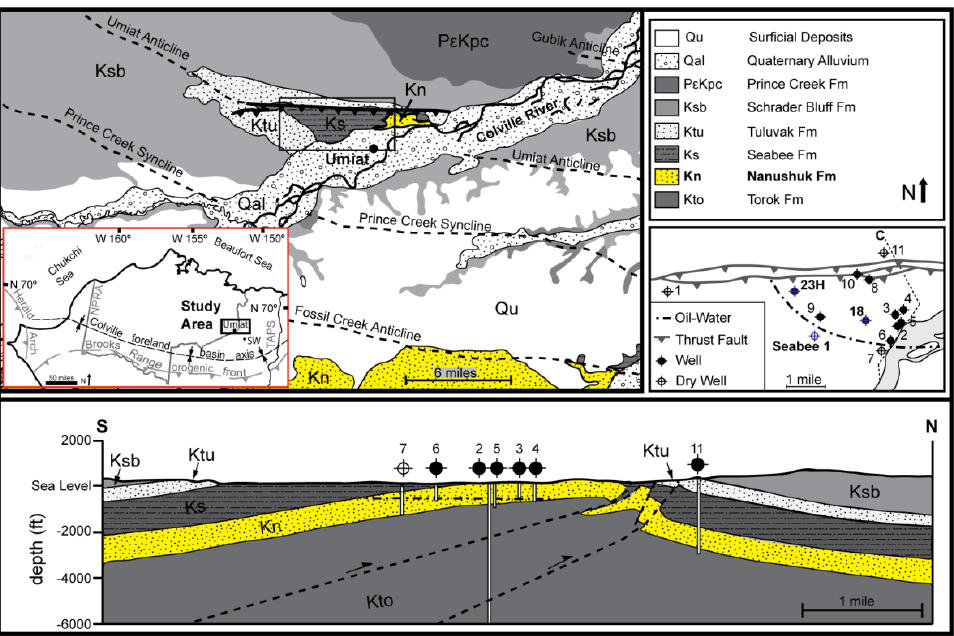
Figure 1. Reference geologic map, well locations, and a generalized cross-section of the Umiat Oil Field, Alaska. Modified from Shimer et al., 2014 [8].